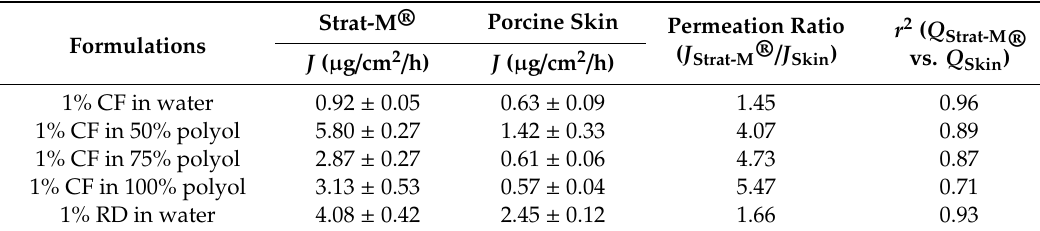
Table 1. Permeation parameters of CF and RD from various formulations through Strat-M ® and porcine skin under finite dose conditions.